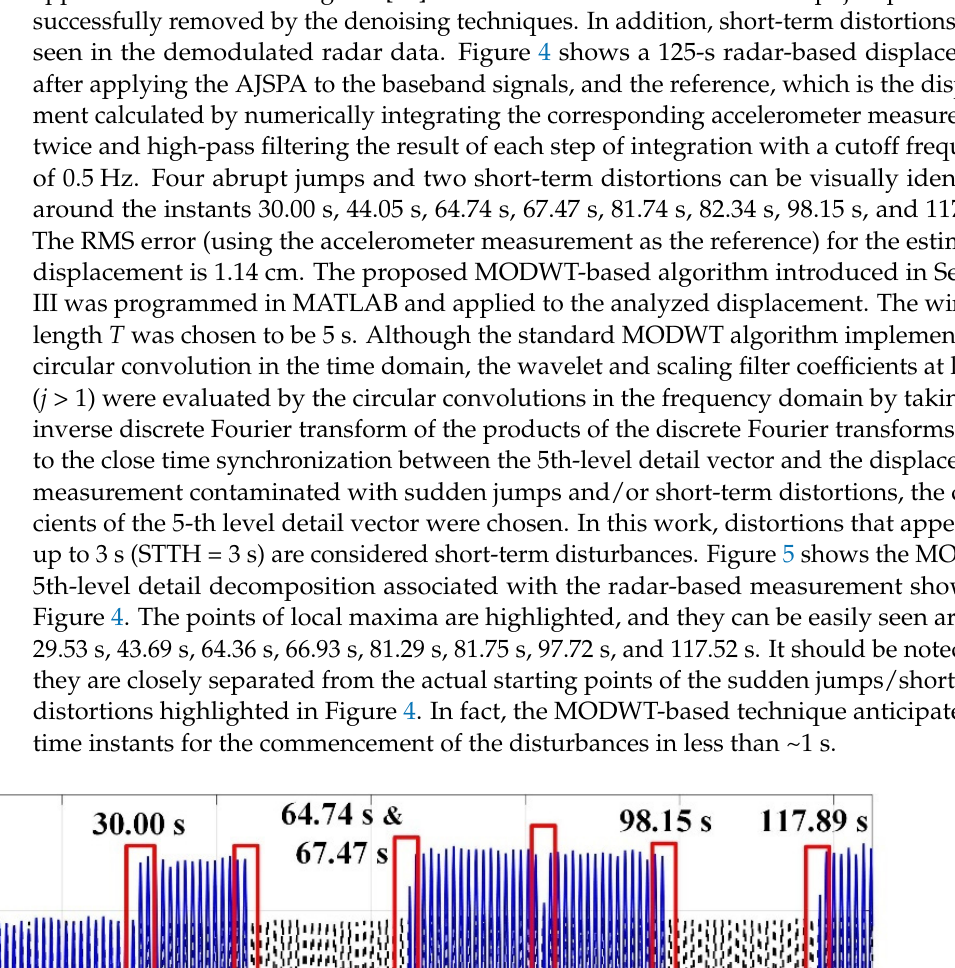
Figure 4. Displacement retrieved by a Doppler radar. The discontinuities are highlighted. Since the changes can be clearly seen on the baseline of the displacement, one can argue that a time-domain-based strategy would be more effective for the identification and removal of jumps/short-term disturbances in phase-demodulated signals. Figure 6 reveals the displacement measurement obtained after applying a corresponding time- domain-based algorithm (TDBA) to the deteriorated measurement shown in Figure 4. The main difference between the TDBA and the proposed MODWT-based technique is that the occurrence of a sudden jump is associated with the absolute difference between the baselines of the first half and the second half of the demodulated displacement for